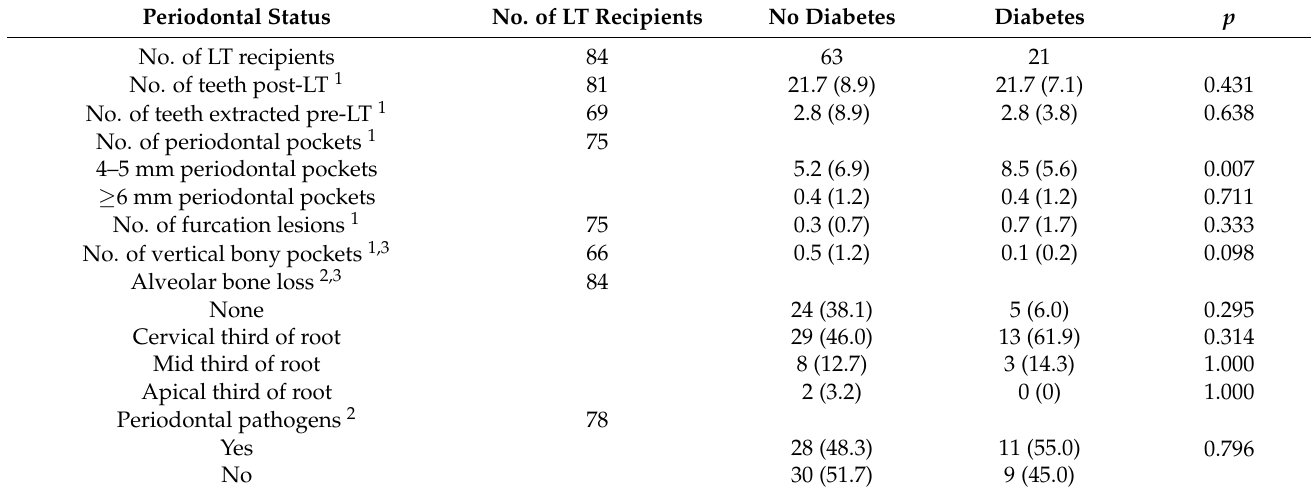
Table 2. Periodontal status and presence of periodontal pathogens in liver transplant recipients with or without diabetes. Periodontal Status